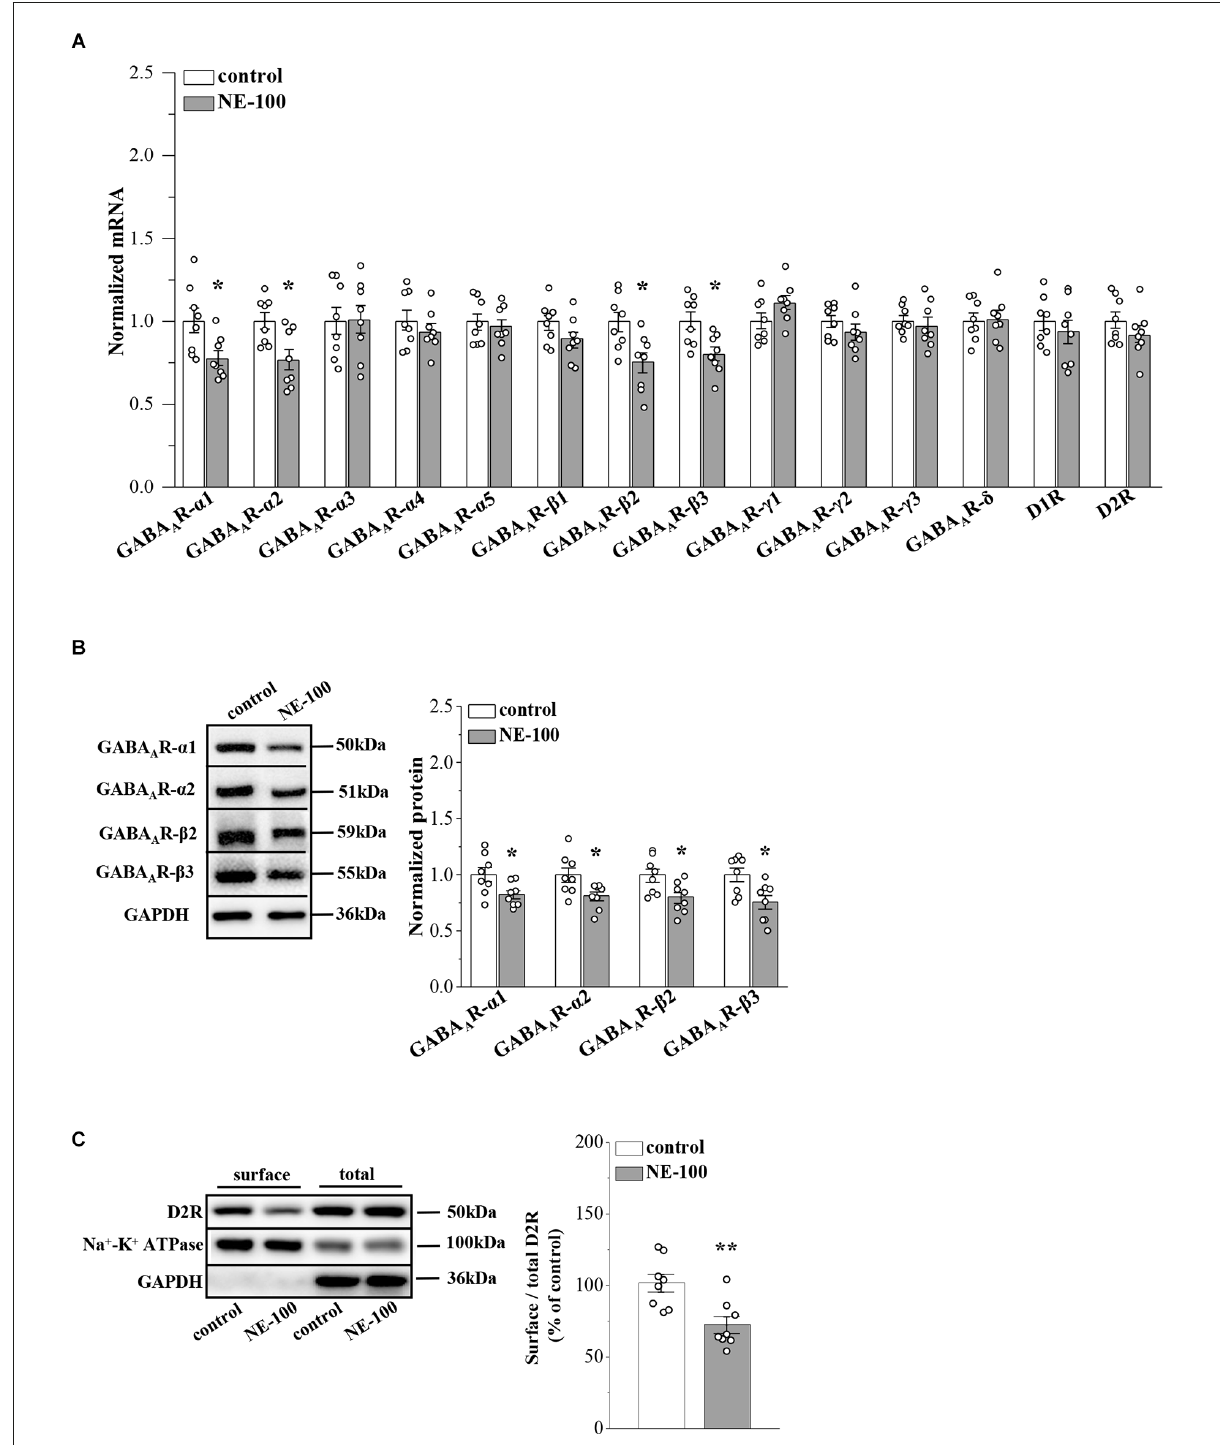
FIGURE3 Repeated injection of NE-100 suppresses GABA A R and D2R expression. (A) The levels of GABA A R- α 1-5 , - β 1-3 , - γ 1-3 , - δ subunits, and D1R , D2R mRNA in the NAc were examined at the end of the behavioral tests. * p < 0.05 vs. control mice ( n = 8 mice per group; two-way ANOVA). (B ) Bar graphs show levels of GABA A R- α 1, GABA A R- α 2, GABA A R- β 2, and GABA A R- β 3 protein in the NAc normalized by the level of GAPDH were normalized by control levels. * p < 0.05 vs. control mice ( n = 8 mice per group; two-way ANOVA). (C) Representative Western blots of biotin- labeled surface proteins (surface) and total proteins (total) D2R in the NAc. Na + -K + ATPase served as internal control and GAPDH served as a negative control. Bar graphs indicate the ratio of proteins at the cell surface to their total levels. ** p < 0.01 vs. control mice ( n = 8 mice per group; Student’s t